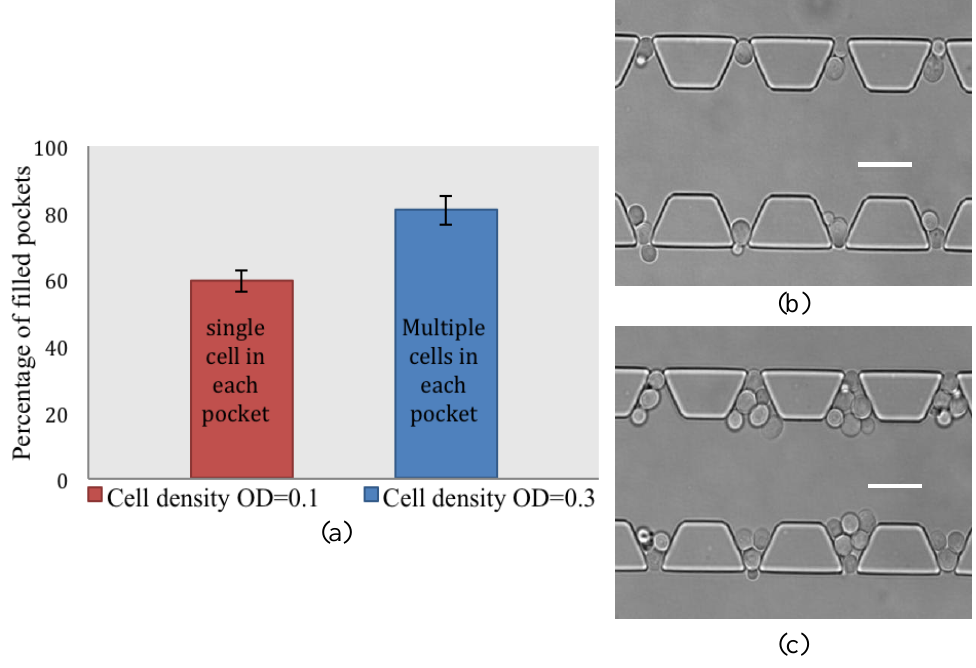
Figure 3. Trapping efficiency in cellcomb microfluidic system. ( a ) Percentage of occupied pockets with two experimentally adjusted cell concentrations. Results indicate that by changing the cell density from OD = 0.1 to OD = 0.3, trapping efficiency increases significantly; ( b ) at lower cell density (OD = 0.1) single cells occupy 60% of the traps; and ( c ) in higher cell concentration (OD = 0.3) multiple cells are trapped in ca. 80% of the pockets. Scale bar is 10